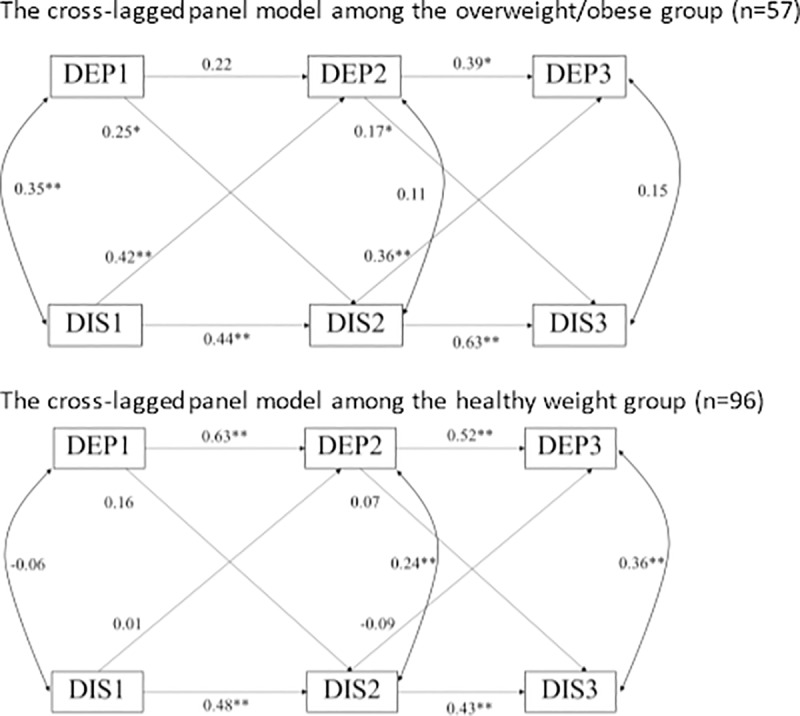
Cross-lagged panel analyses on body dissatisfaction and depressive symptoms over time among Black adolescents of overweight/obese group (upper part) and healthy weight group (lower part), separately. DEP1-DEP3 indicate depressive symptoms at time 1, time 2 and time 3, separately. DIS1-DIS3 indicate body dissatisfaction at time 1, time 2 and time 3, separately. The model for the overweight/obese group controls for maternal education, intervention and poverty. The model for the healthy weight group controls for sex, intervention and adolescents’ age. To simply the figures, the covariates were not depicted in the figure. Standardized estimate βs were presented. * indicates p = 0.05–0.10. ** indicates p <0.05.